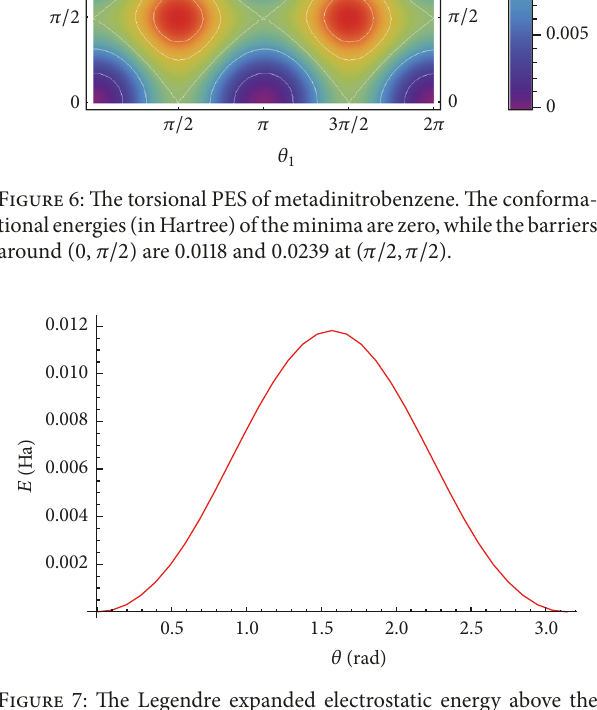
Figure 7: The Legendre expanded electrostatic energy above the minimum as a function of the C-N bond angles is plotted for the metaisomer.